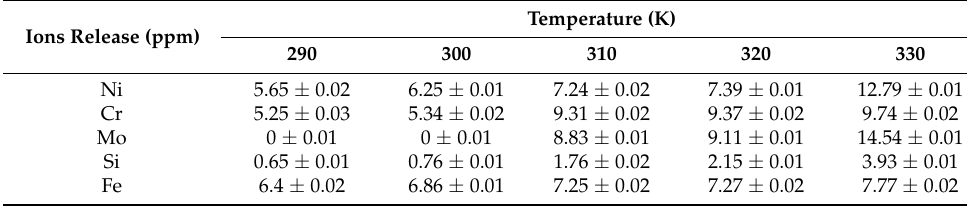
Table 4. Ions release for NiCr alloy at 290, 300, 310, 320 and 330 (K). Ions Release